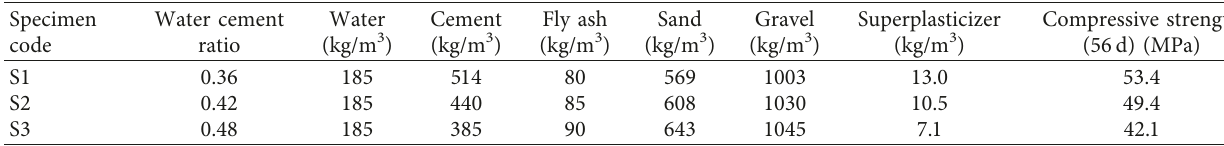
Table 4: Mixture proportions for a cubic meter of concrete.